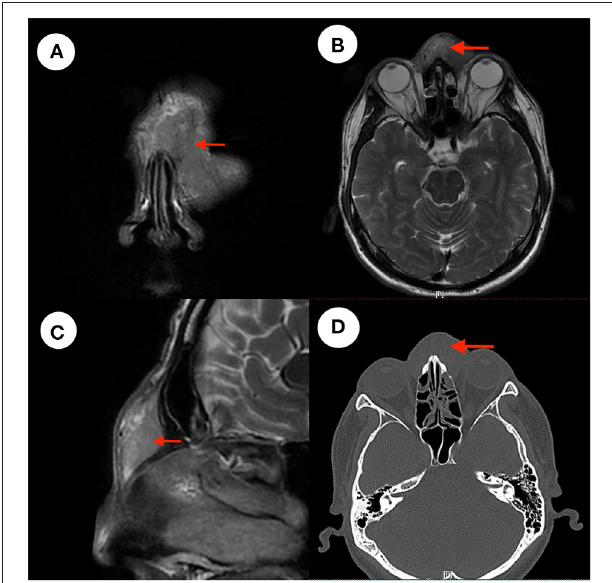
FIGURE 1 | CT and MRI images. (A–C) Show iso- and hyper-intense signal in T2 sequence of the patient’s cranium MRI images. Panel (A) is a coronal T2 image. Panel (B) is an axial T2 image. Panel (C) is a sagittal T2 image. Panel (D) is a CT image, with the red arrow indicating the mass.